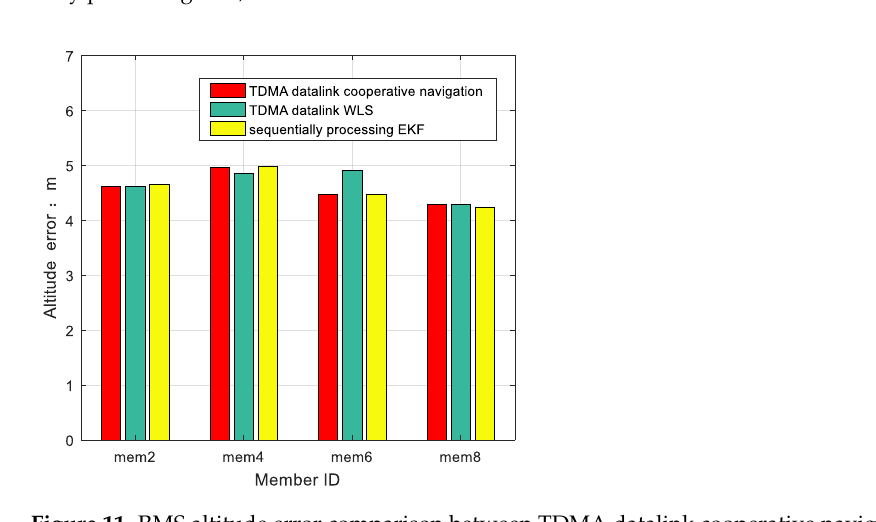
Figure 11. RMS altitude error comparison between TDMA datalink cooperative navigation, sequentially processing EKF, and TDMA datalink WLS.